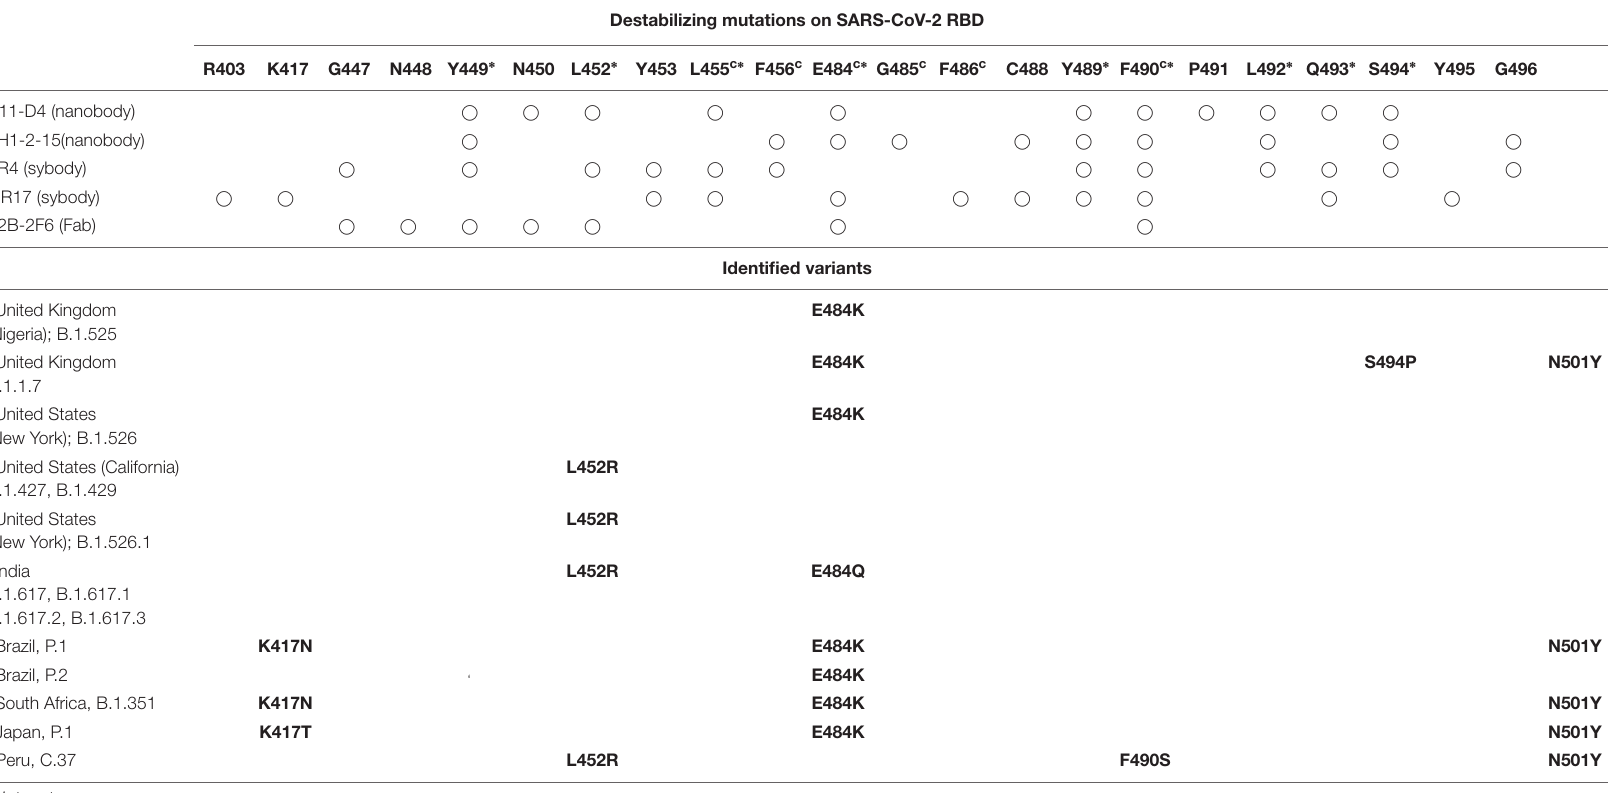
TABLE 1 | Mutation sites destabilizing SARS-CoV-2 RBD binding to neutralizing antibodies.